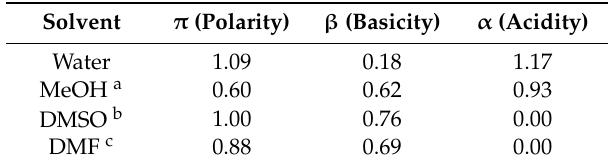
Table 2. Properties of four solvents used for the glucose isomerization. Solvent